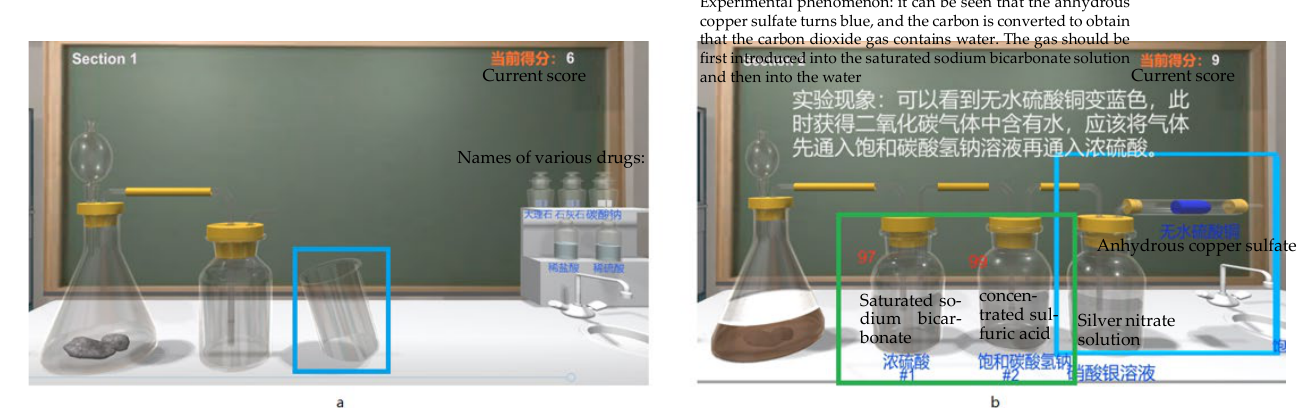
Figure 9. Limestone and dilute hydrochloric acid experiment scene 4. ( a ). Beaker operation interface. ( b ). The second test phenomenon interface.